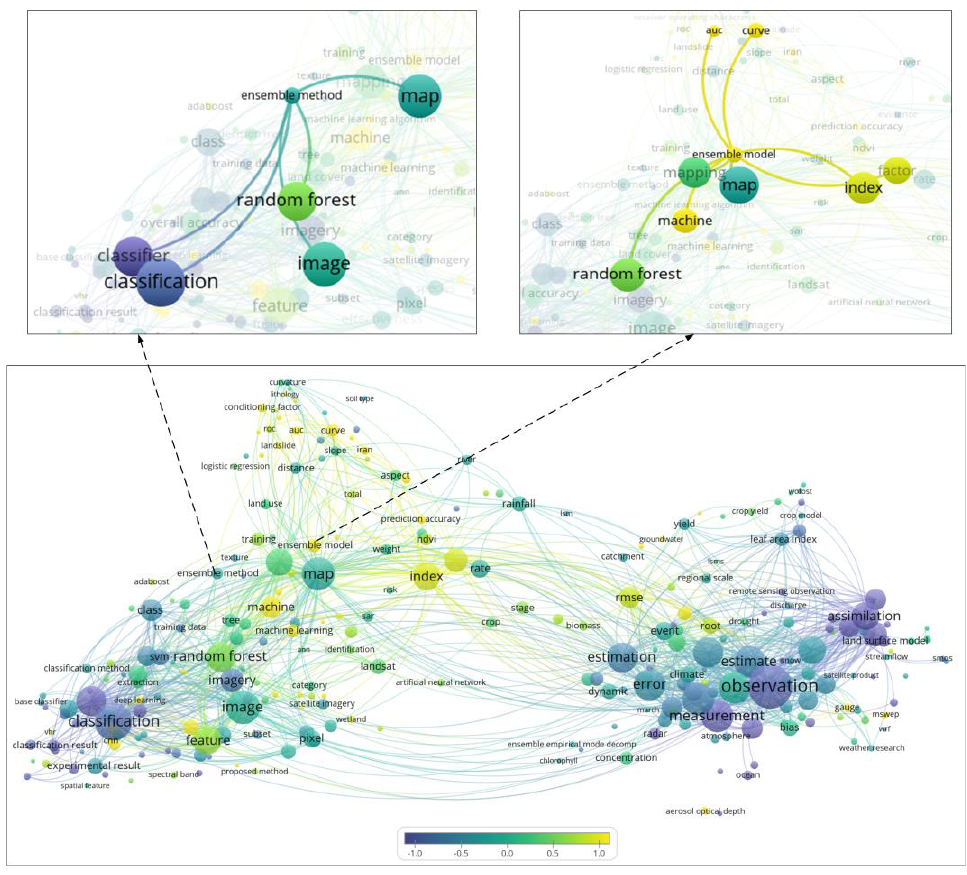
Figure 2. Co-occurrence network of keywords in ensemble literature.